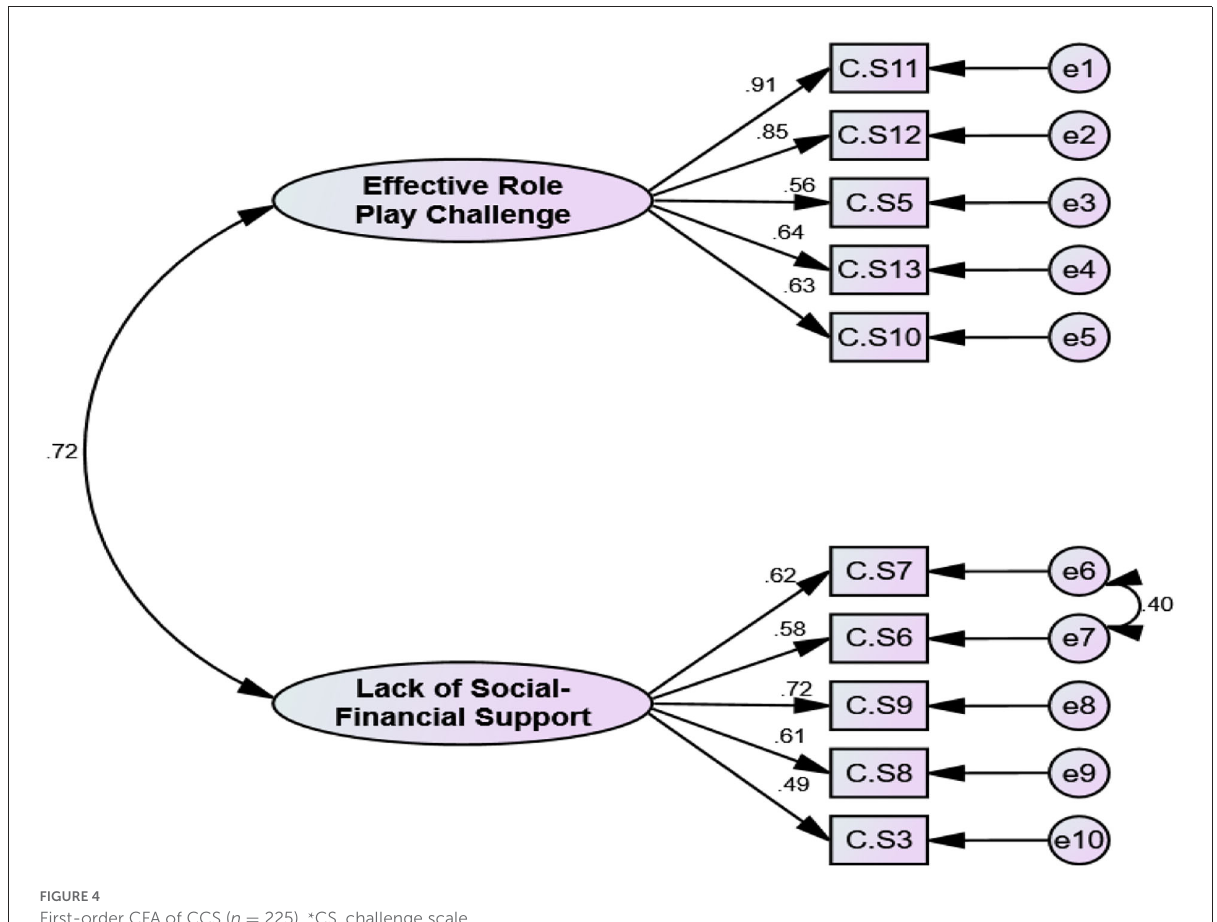
225). * CS, challenge scale. =